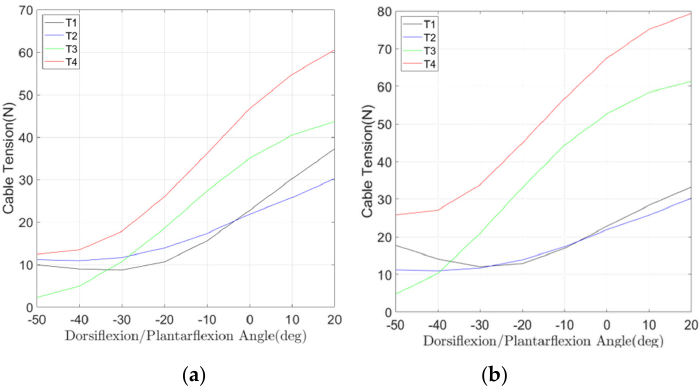
Figure 6. Flowchart of the designed control system for CABLEankle device.